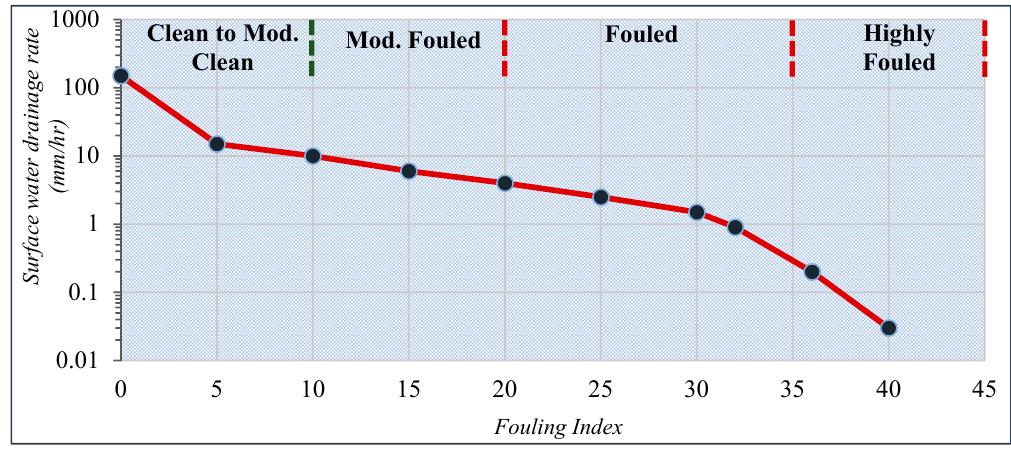
Figure 12. Surface water drainage rate and FI relationship (Mod. = moderately) [28].